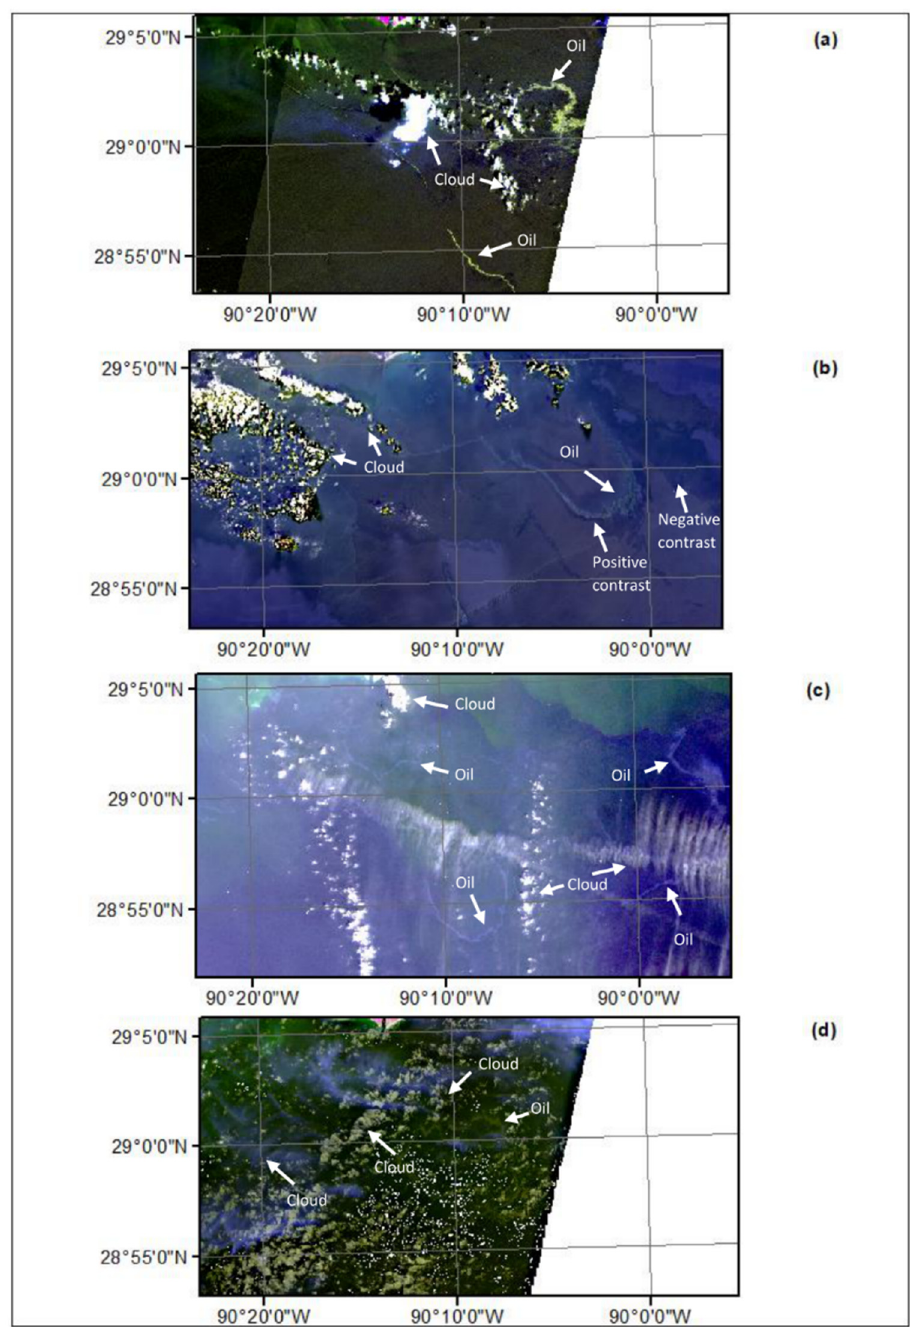
Figure 8. Natural color composite. ( a ) Sentinel-2 (4, 3 and 2) bands on 2 September 2021, ( b ) Landsat- 8 (4, 3 and 2) bands on 3 September 2021, ( c ) Sentinel-2 (4, 3 and 2) bands on 4 September 2021, ( d ) Sentinel-2 (4, 3 and 2) bands on 7 September 2021.